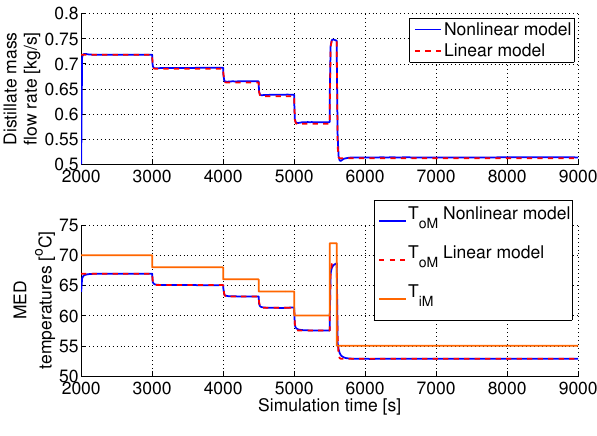
Figure 5. Results obtained with the MED unit first-order model.